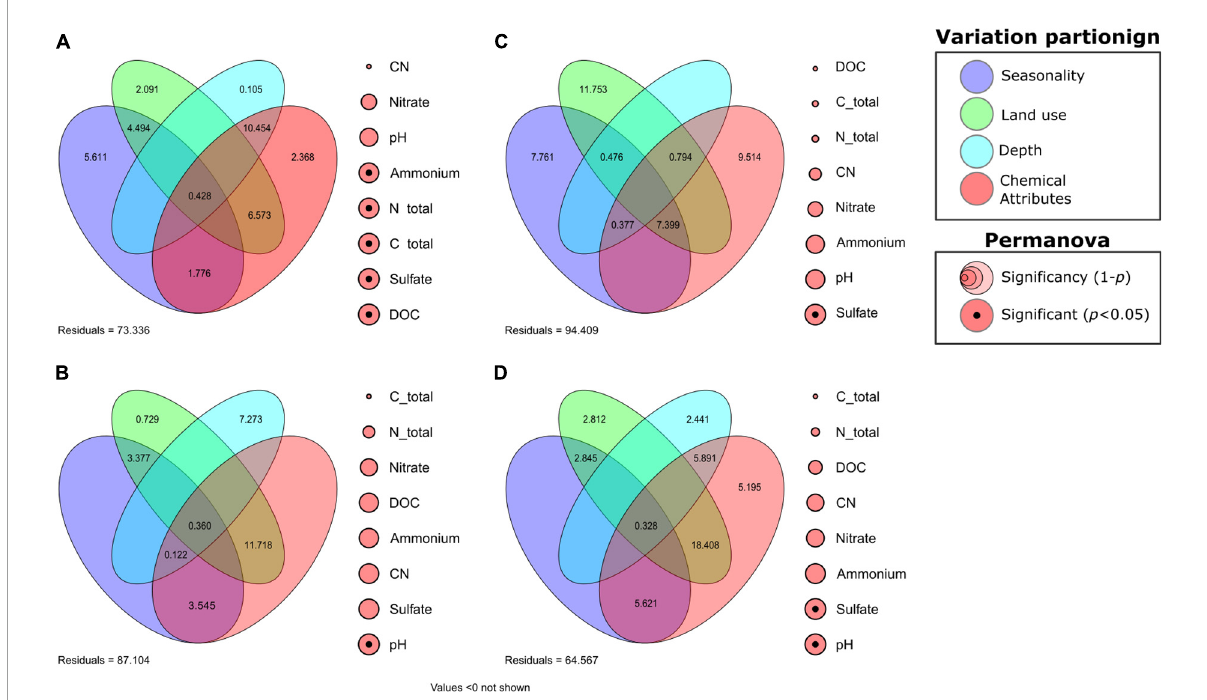
FIGURE3 Variance partitioning of the active ammonia-oxidizing and nitrogen-dependent anaerobic methane-oxidizing communities, followed by the permutational analysis of variance of each chemical attribute. (A) Ammonia-oxidizing archaea (AOA), (B) ammonia-oxidizing bacteria (AOB), (C) Methanoperedens , and (D) Methylomirabilis .